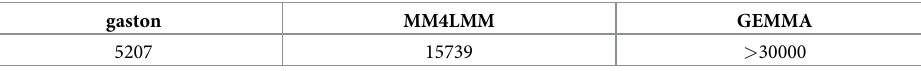
Table 4. Computational time (in sec.) associated to the analysis of the NAM dataset using Model (3). gaston MM4LMM GEMMA 5207